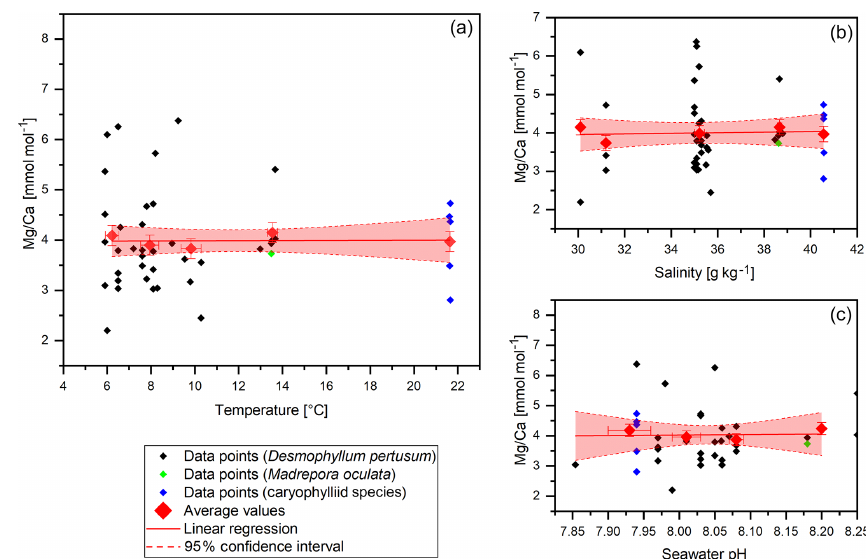
Figure 4. Mg / Ca data (without COC) plotted against water temperature, salinity and pH. Red diamonds indicate averaged values for tem- perature ranges. Temperature ranges are 5–7, 7–9, 9–11, 13–15 and 21–23 ◦ C. The x error relates to the SD of the temperature or salinity mean. The y error bars indicate 2SD of the JCp-1 mean. Red lines are linear regressions of the averaged values with the 95% confidence interval